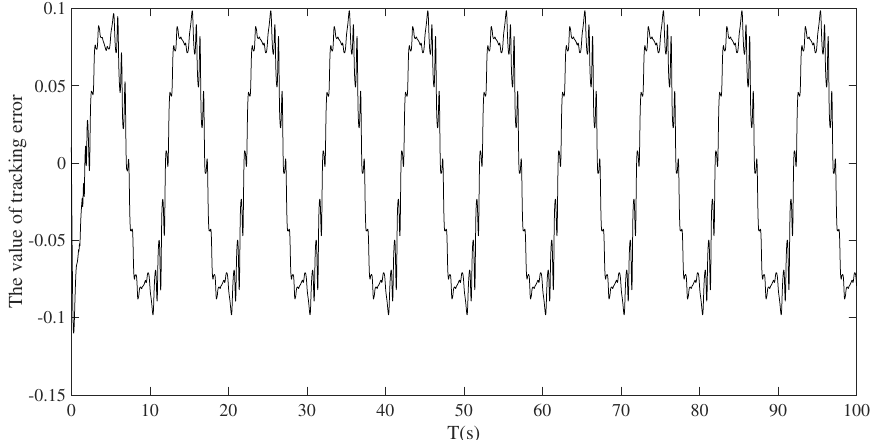
Figure 8. Tracking error curve in unknown time-varying delay form (with dead-zone compensation